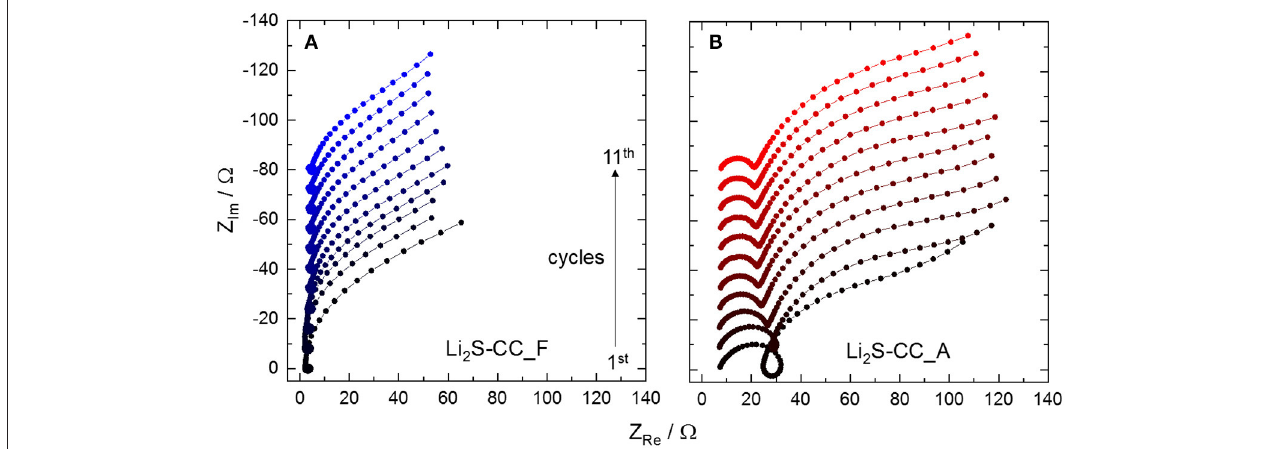
FIGURE 3 | Evolution of the electrochemical impedance spectra from the first to the eleventh cycle of (A) Li 2 S-CC_F and (B) Li 2 S-CC_A. The baselines of the spectra are shifted upward for clarity. All spectra were taken on 3-electrode cells in the discharged state.